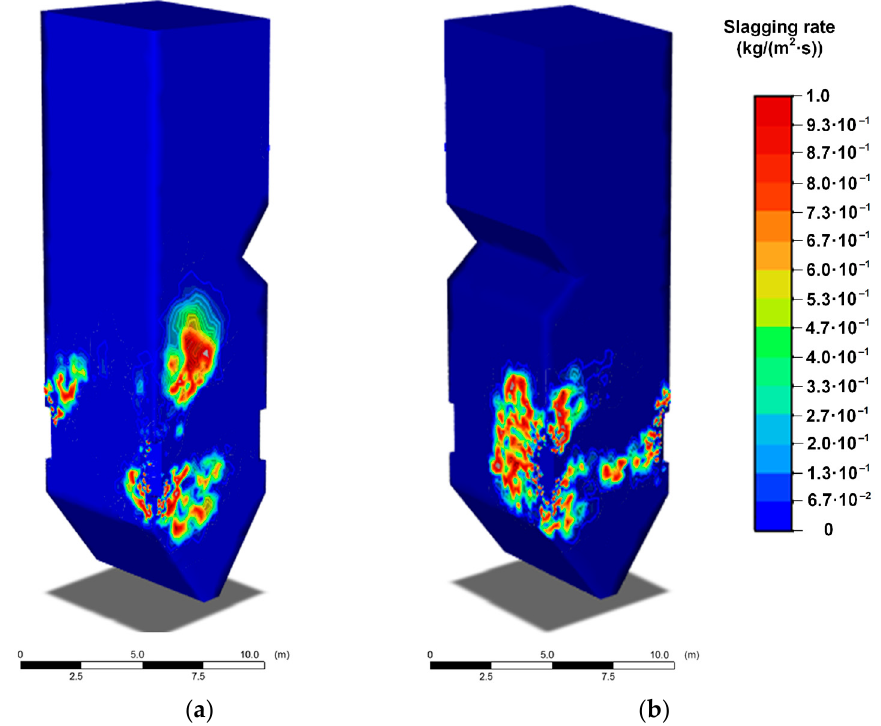
Figure 6. Typical fields of slagging rates of furnace walls when burning coal: from the front side of the furnace ( a ); from the back side of the furnace ( b ).